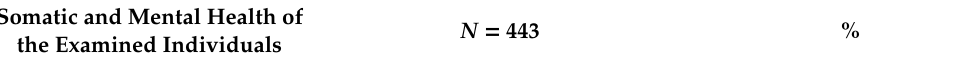
Table 3. Somatic and mental health of the examined individuals ( N = 443).